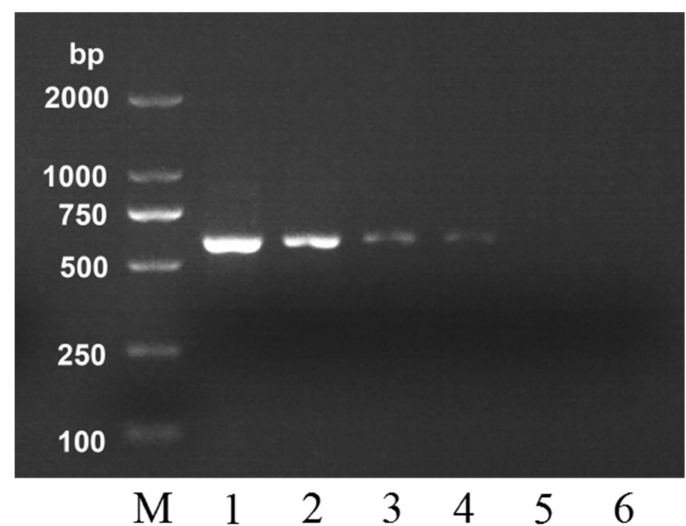
Figure 2. Agarose gel electrophoresis of PCR products using A. mellifera honey specific primers with a serial dilution of A. mellifera honey DNA extract. Lane M, DNA marker; Lane 1, 100 ng; lane 2, 10 ng; lane 3, 1 ng; lane 4, 0.1 ng; lane 5, 0.01 ng; lane 6, negative control.